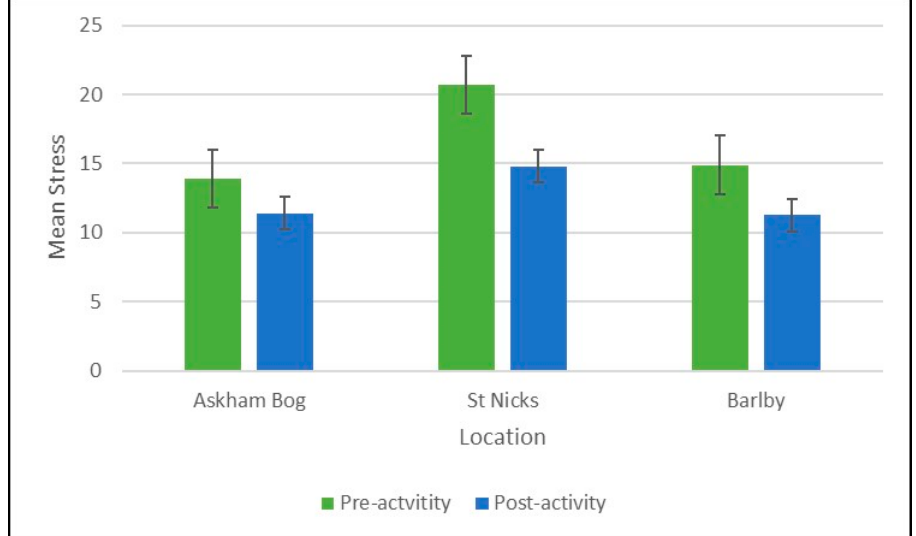
Figure 5. Mean pre- and post-stress scores by location .